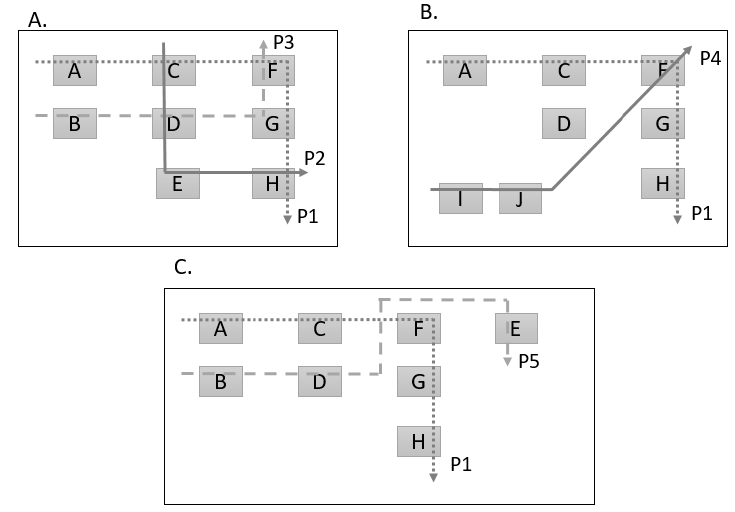
Figure 2. Factory layout dynamics.